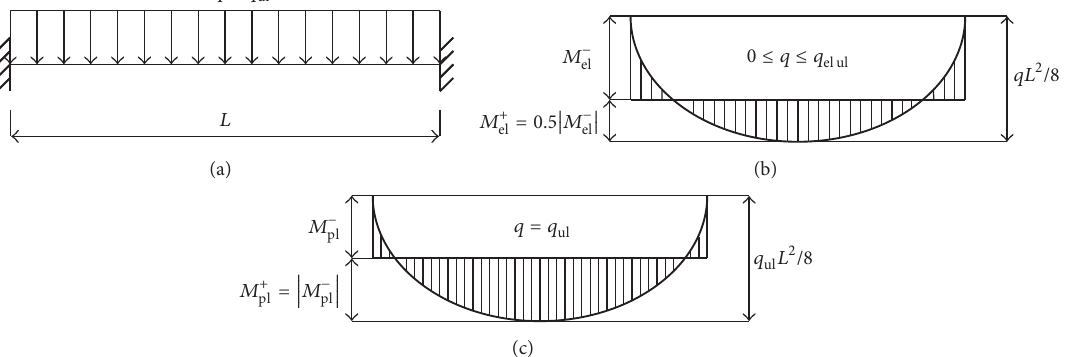
Figure 4: Structural phenomenon evidence for a fixed concrete beam: (a) static scheme, (b) bending moments diagram in elastic stage, and (c) bending moments diagram in ultimate limit